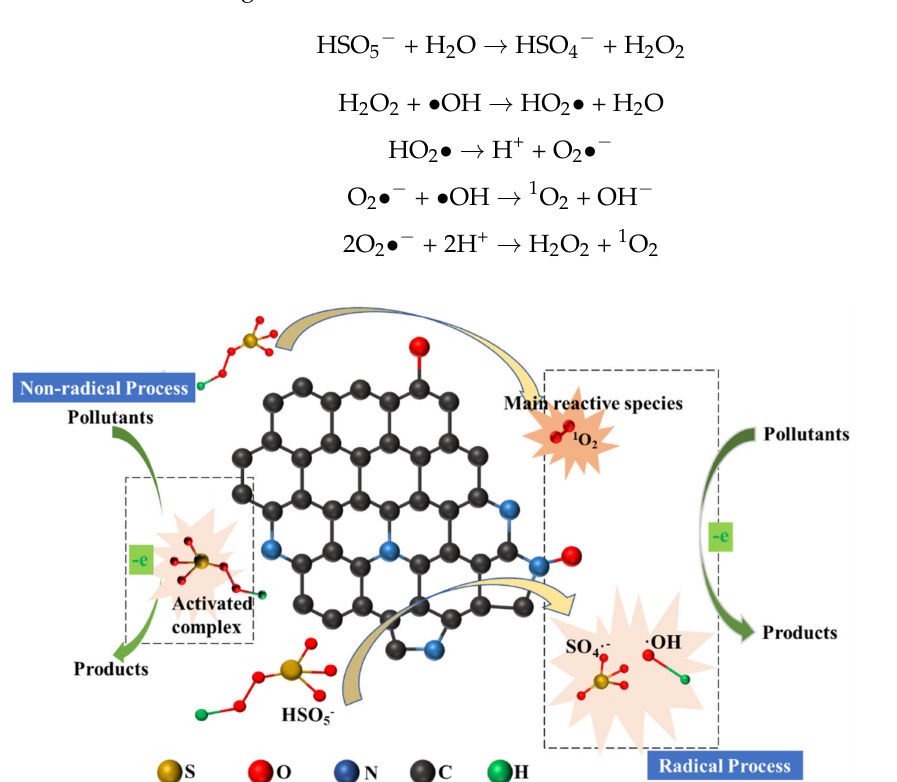
Figure 2. Mechanism of PMS activation and pollutants degradation over nitrogen-doped sludge carbon catalyst